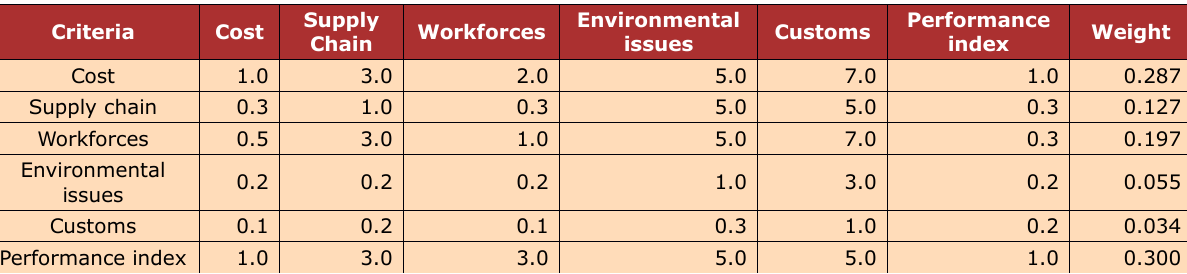
Table 2. Pair-wise comparison matrix of